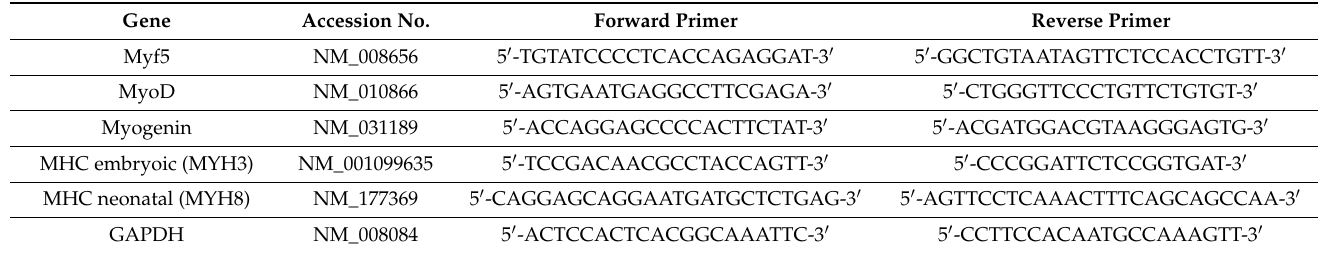
Table 1. Primer sequence using semi-quantitative reverse transcription-polymerase chain